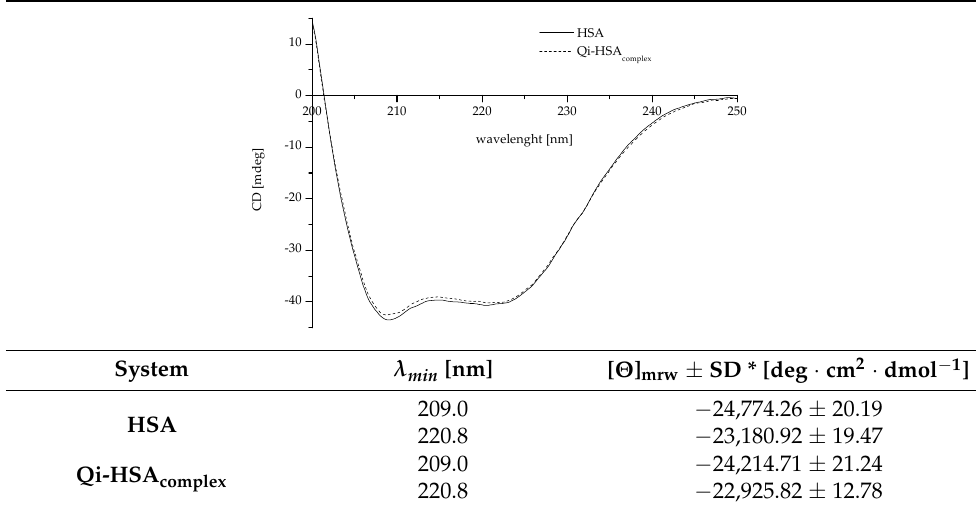
Table 3. The CD spectra and the values of mean residue ellipticity [ Θ mrw ] for HSA, in both the absence and presence of Qi (Qi:HSA 6.67:1 molar ratio); [HSA] 3 × 10 − 6 M; [Qi] 1 × 10 − 3 M; pH = 7.4.